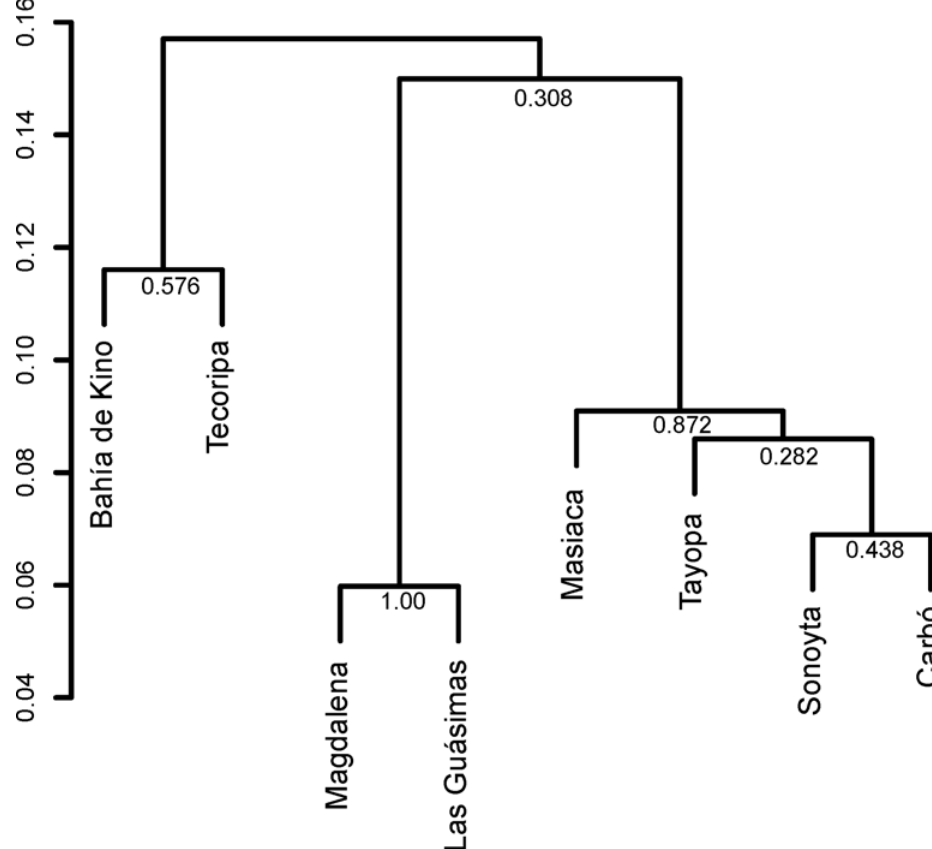
Fig 4. Dendrogram (UPGMA) showing the relations among the studied populations of S . thurberi using the Rousset ’ s [68] genetic distance Fst/(1-Fst). At each node is the value of bootstrap that supports